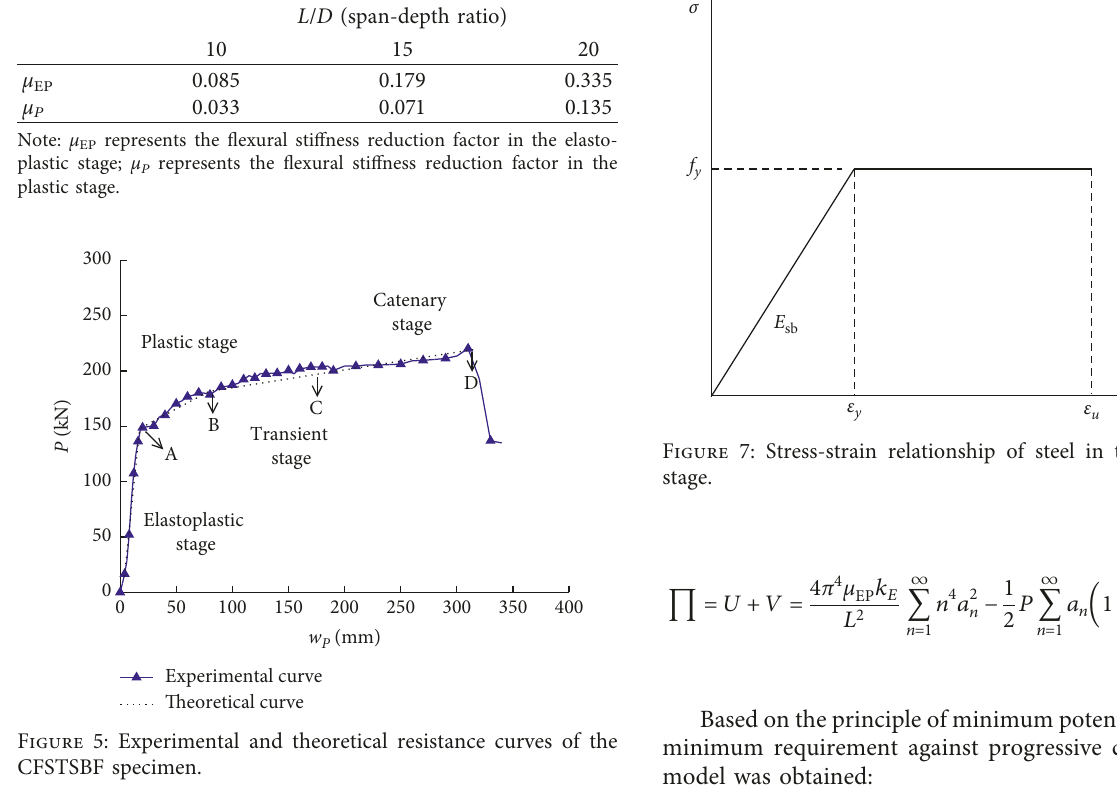
Figure 4: Resistance curve of the CFSTSBF specimen. Table 1: Flexural stiffness reduction factors ( μ ).